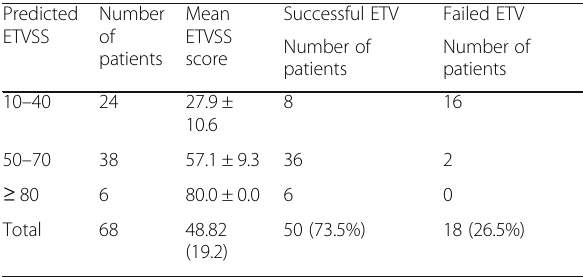
Table 4 The relationship between predicted ETVSS